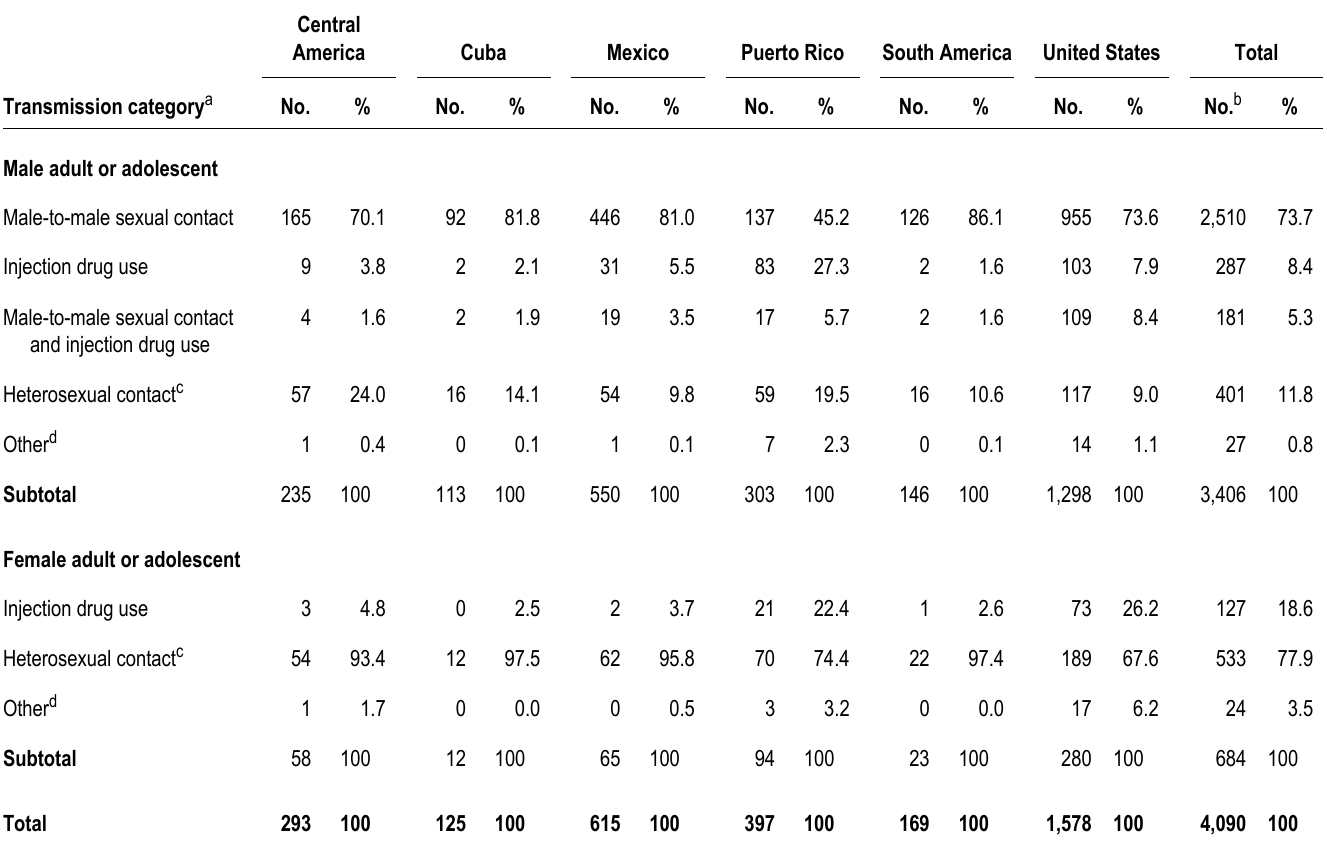
Table 11. Stage 3 (AIDS) among adult and adolescent Hispanics/Latinos, by transmission category and place of birth, 2015— United States and 6 dependent areas Central America Cuba